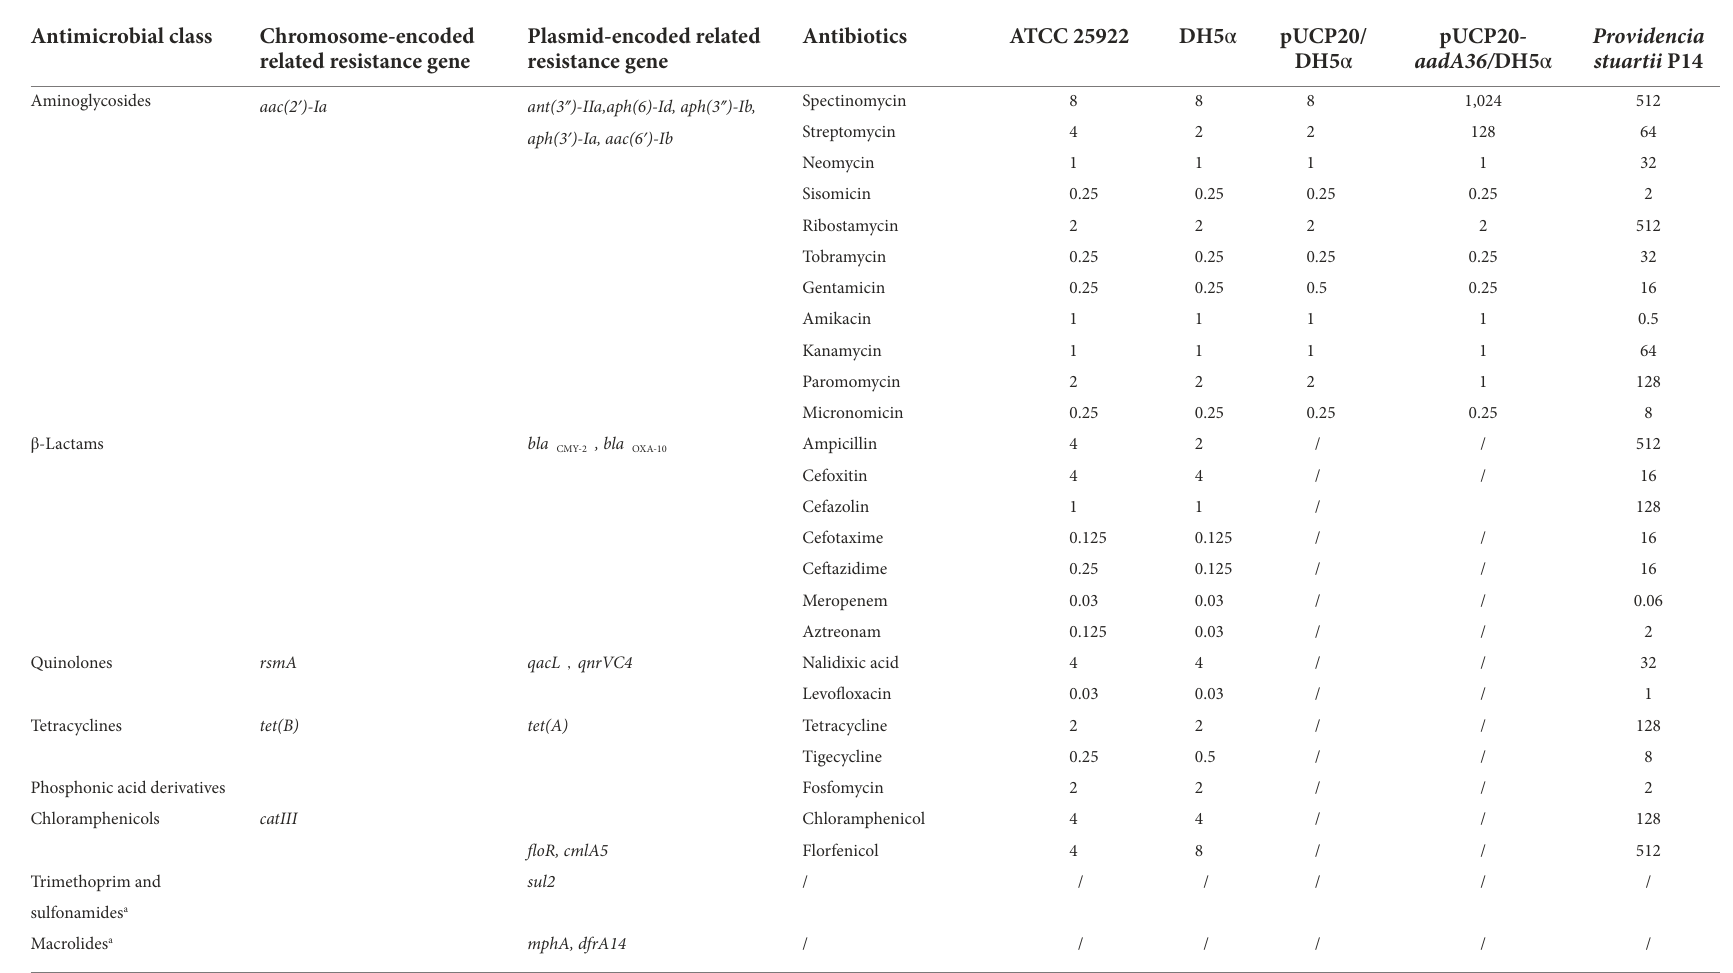
TABLE 4 MICs of 25 antimicrobials for 5 strains( μ